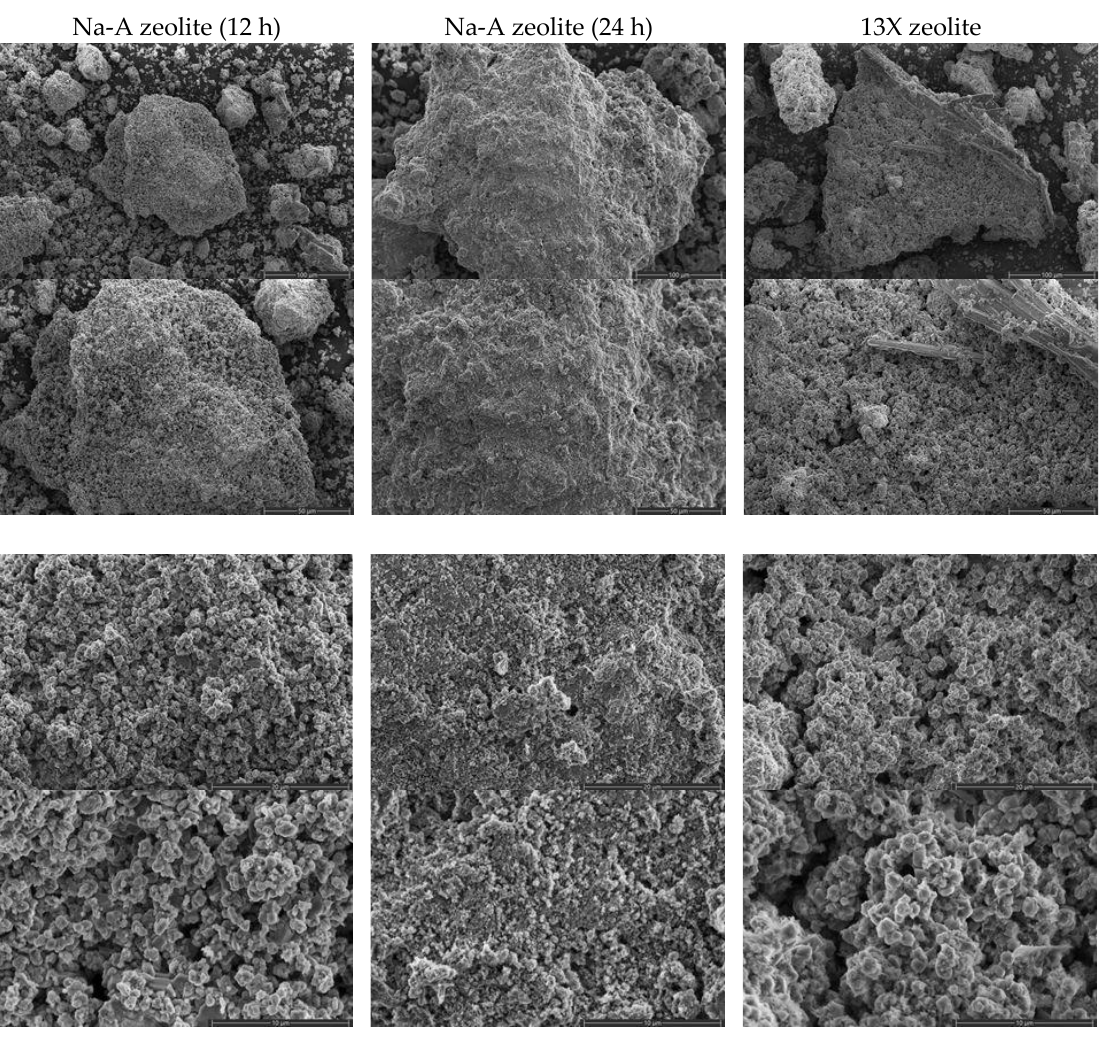
Figure 3. Morphology of synthesized zeolites.